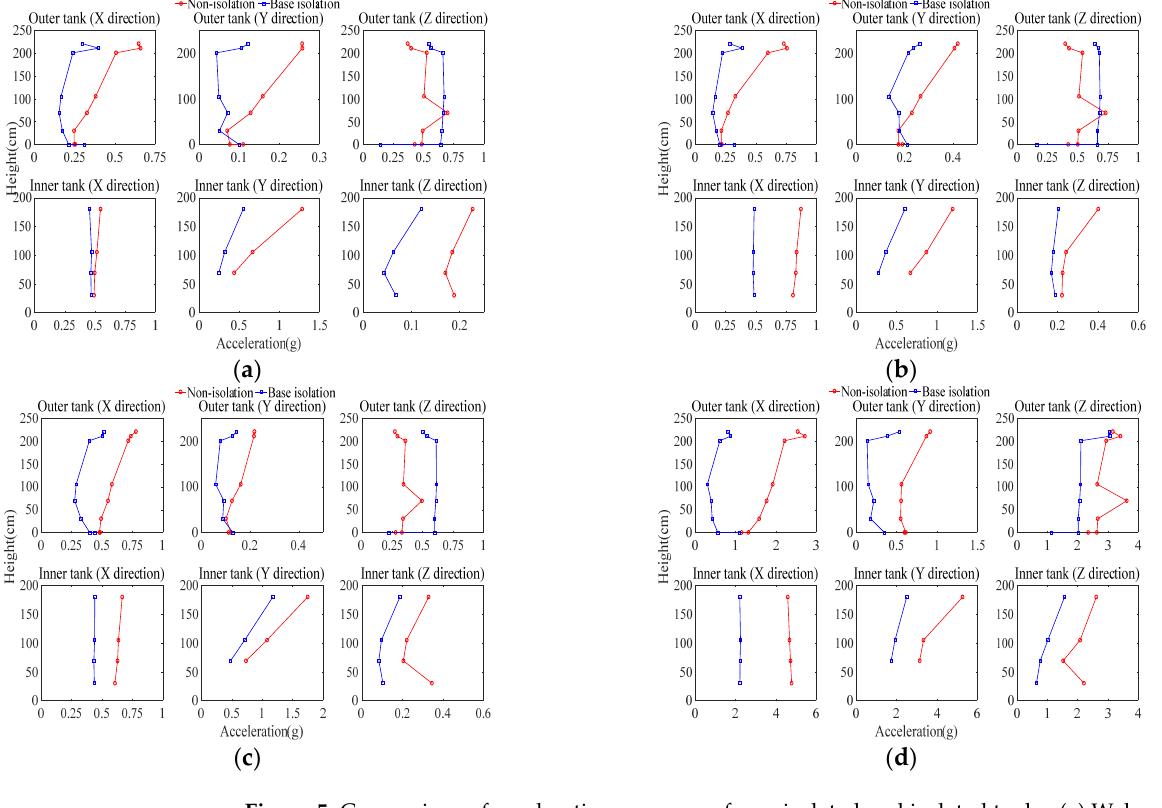
Table 4. Comparison of the maximum displacement response of the tank dome under different working conditions